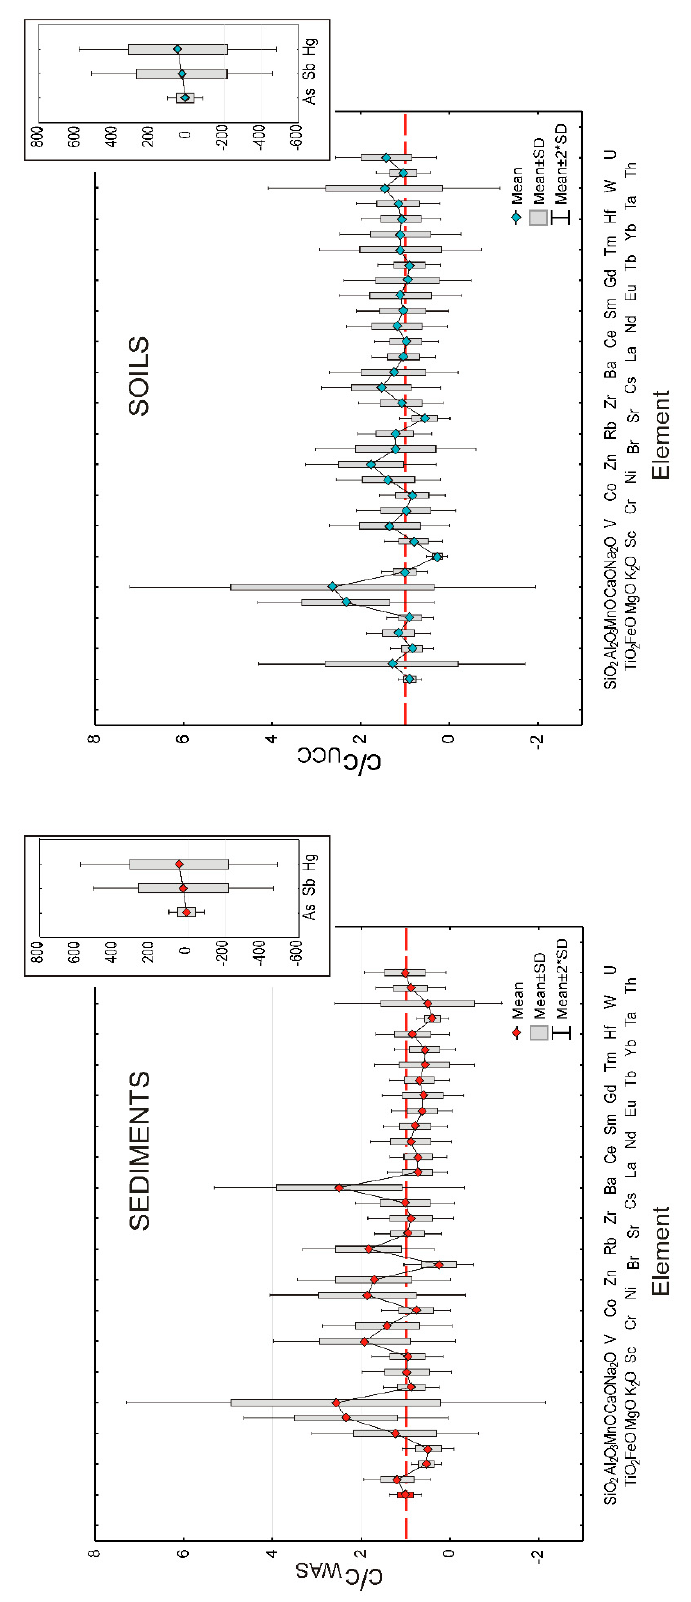
Figure 2. Box-plots illustrating the distribution of investigated elements in Zarafshon sediments ( lower ); and soils ( upper ). All mass fractions of soils normalized to UCC [17] and sediments to SMWR [19]. The values corresponding to As and Hg are divided by 10 and by 100 in the case of Sb.